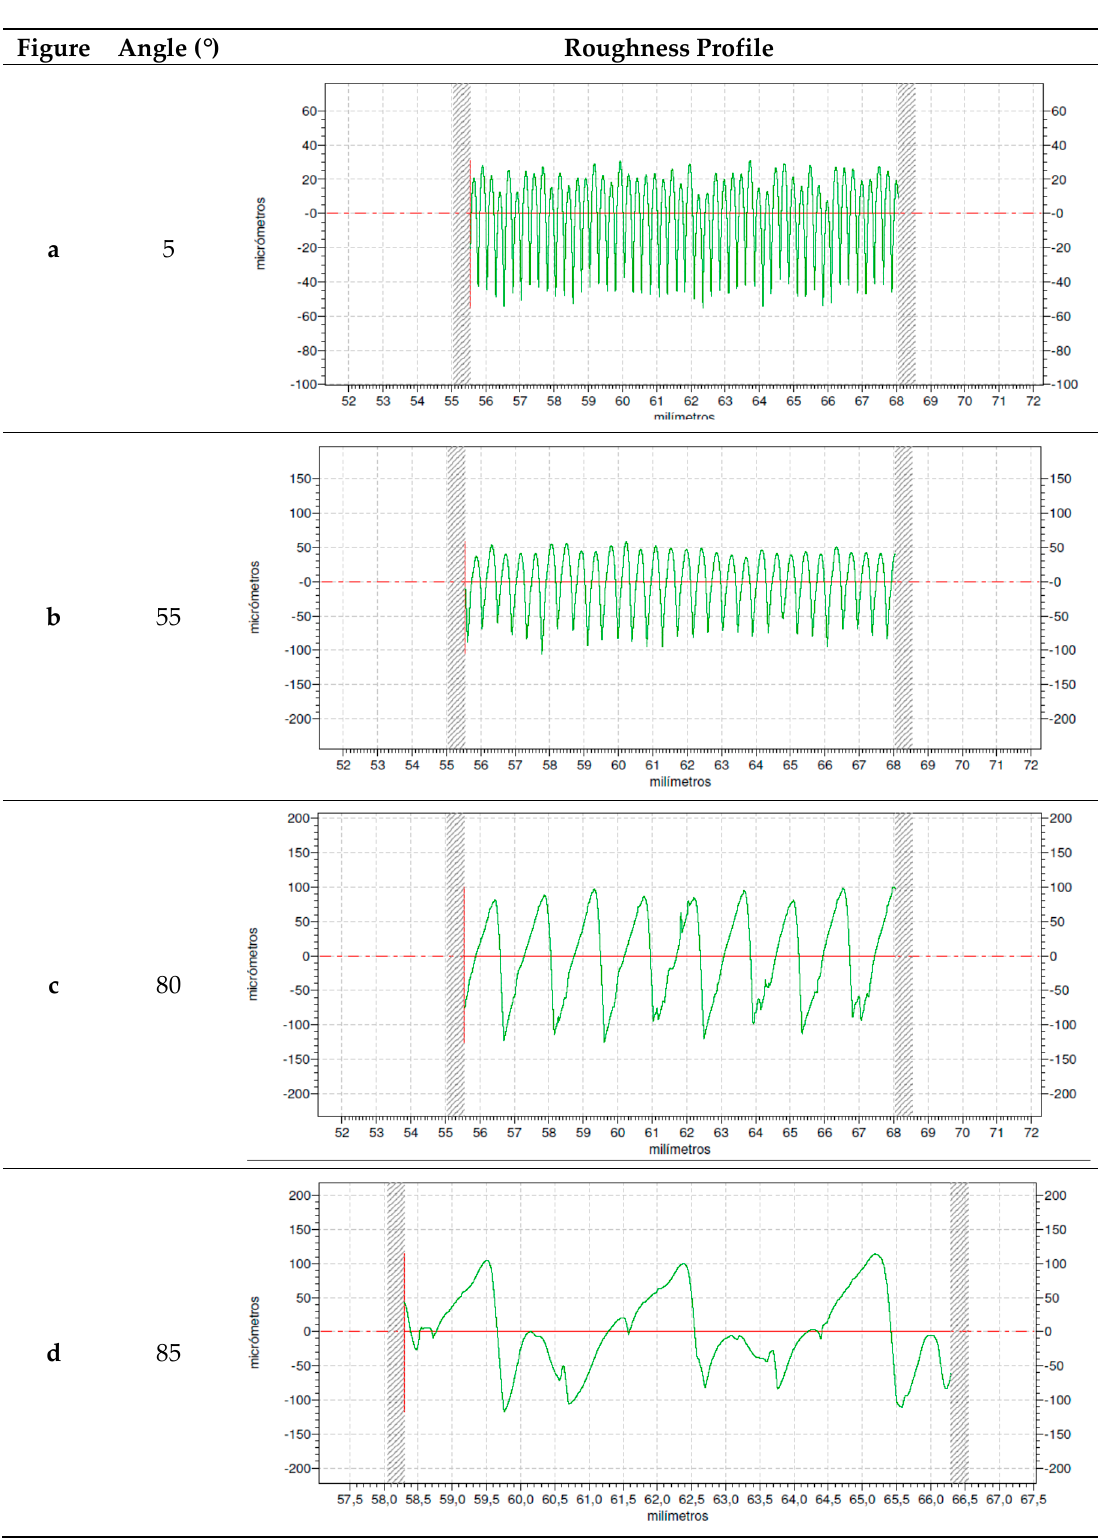
Figure 8. Roughness profiles for print orientation angle of: ( a ) 5°, ( b ) 55°, ( c ) 80°, and ( d ) 85° .